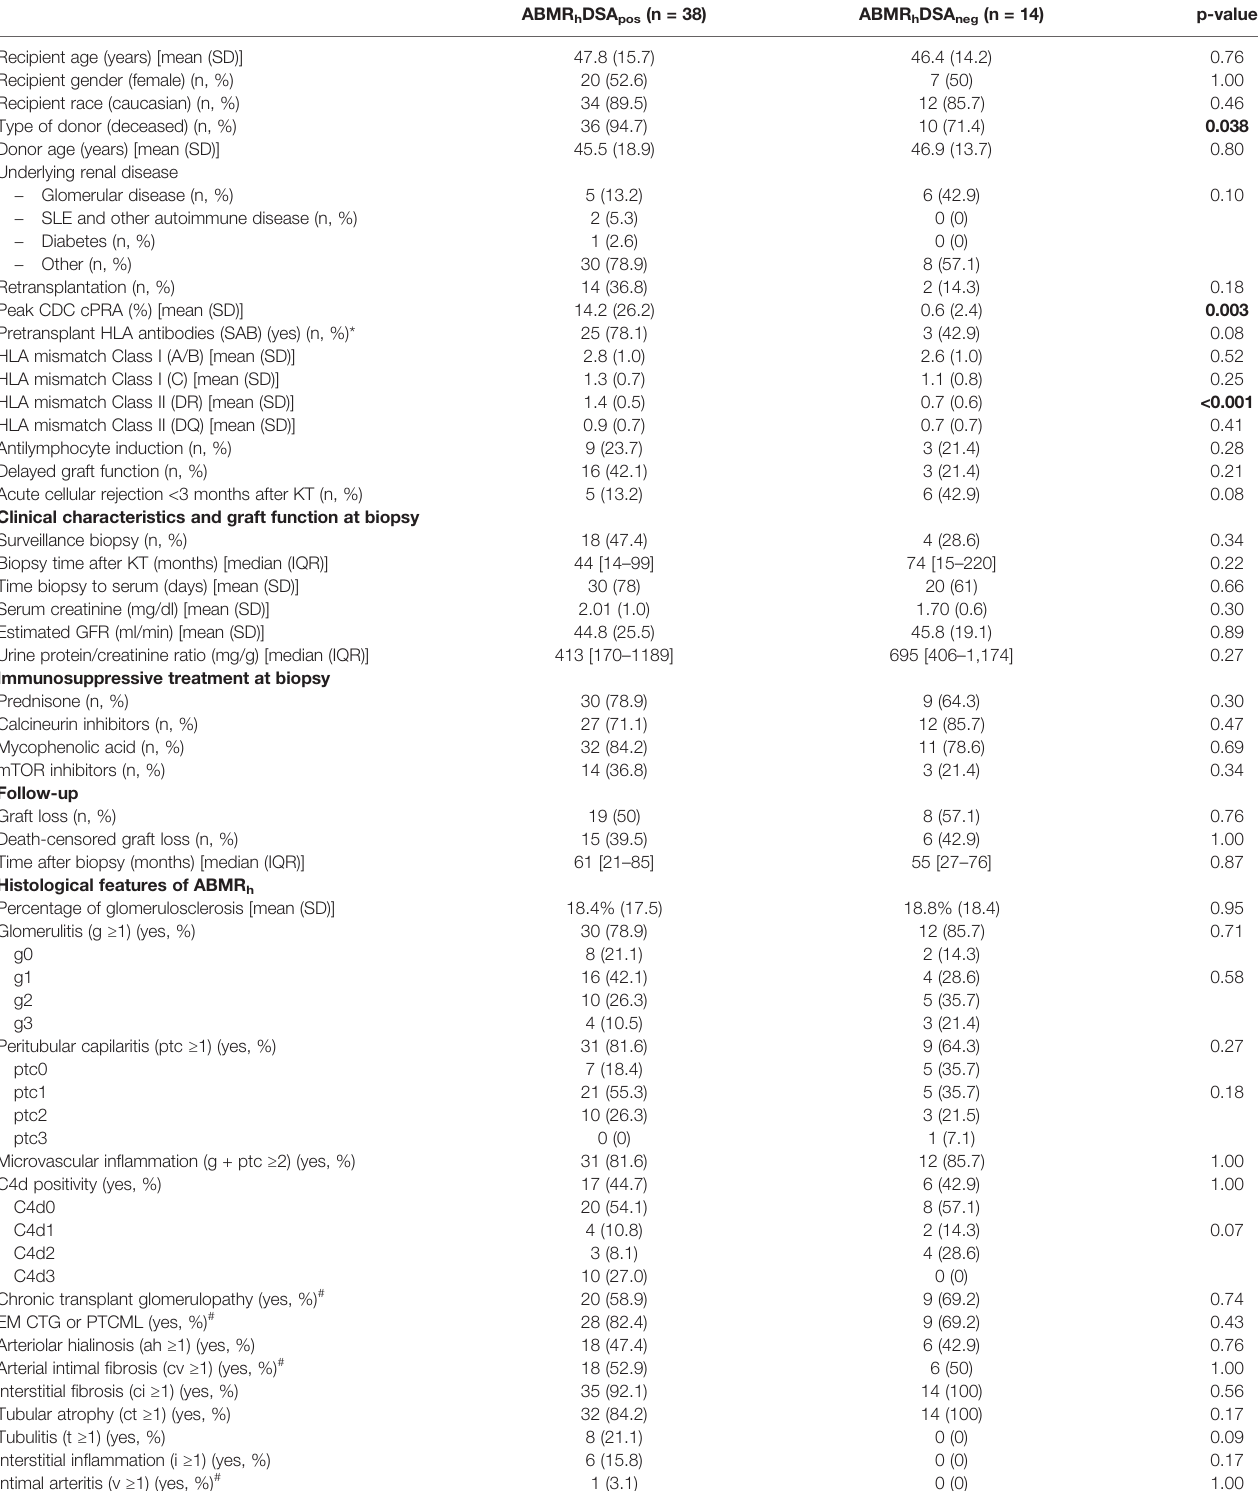
TABLE 2 | Characteristics of patients with and without